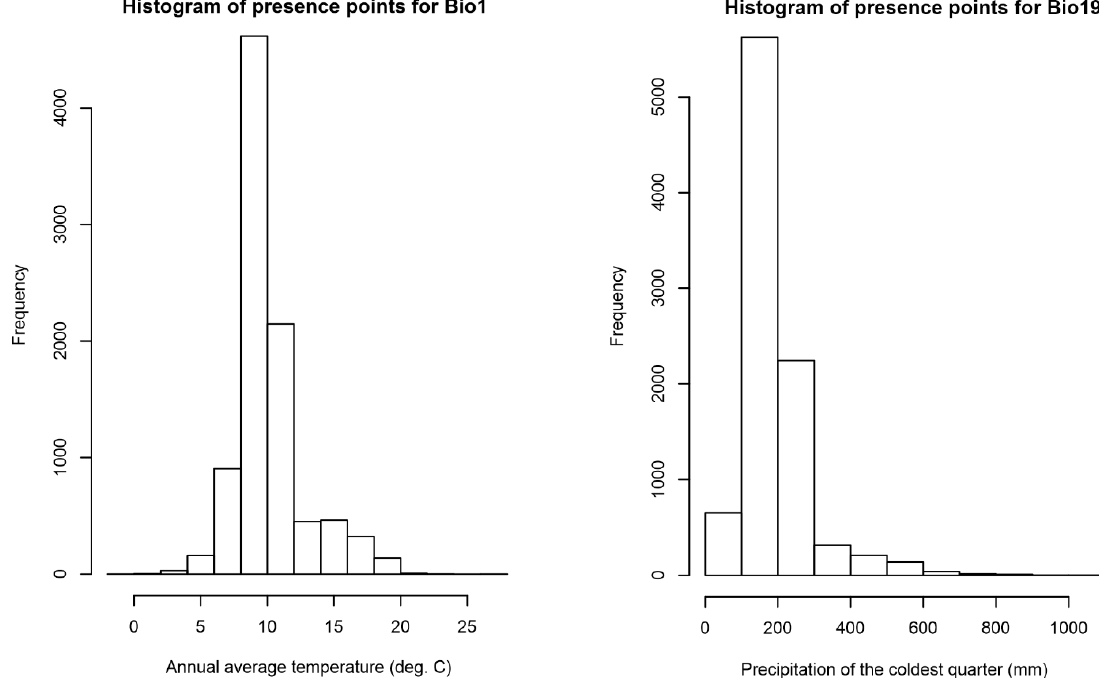
Figure 5. Histograms showing the distribution of bioclimatic values at known occurrences of P. dominula. Left is the distribution of annual average temperature (Bio1) and on the right the distribution of precipitation of the coldest quarter (Bio19). These two variables were chosen from the full list of 15, based on their high permutation importance in the MAXENT modelling approach.